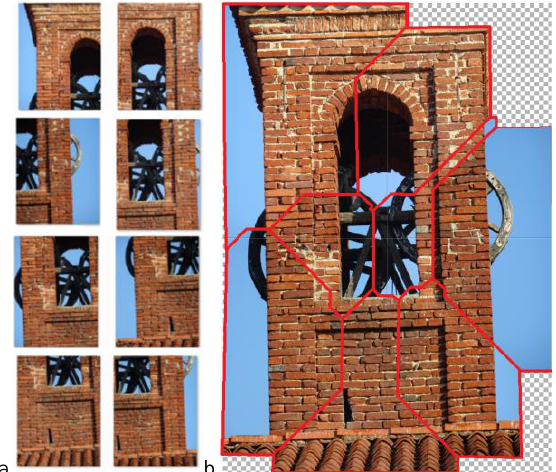
Figure 9. Stitching of the images to generate a gnomonic projection: (a) the original picture; and (b) the gnomonic projection obtained as a mosaic.